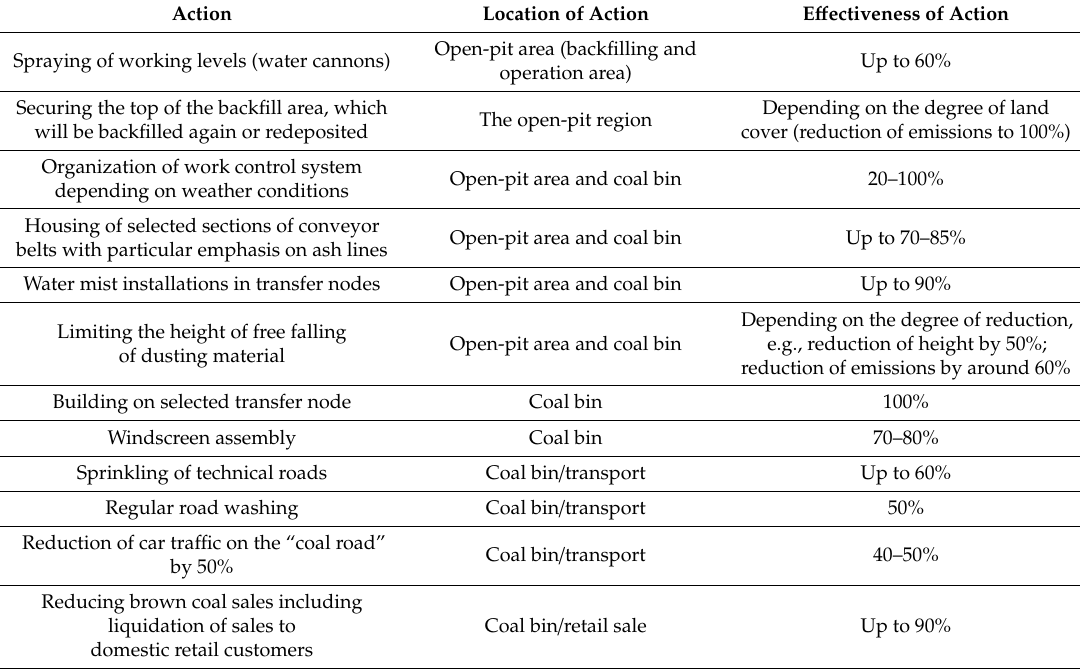
Table 6. Measures to minimize the impact of KWBT on air quality in Bogatynia commune (on the basis of